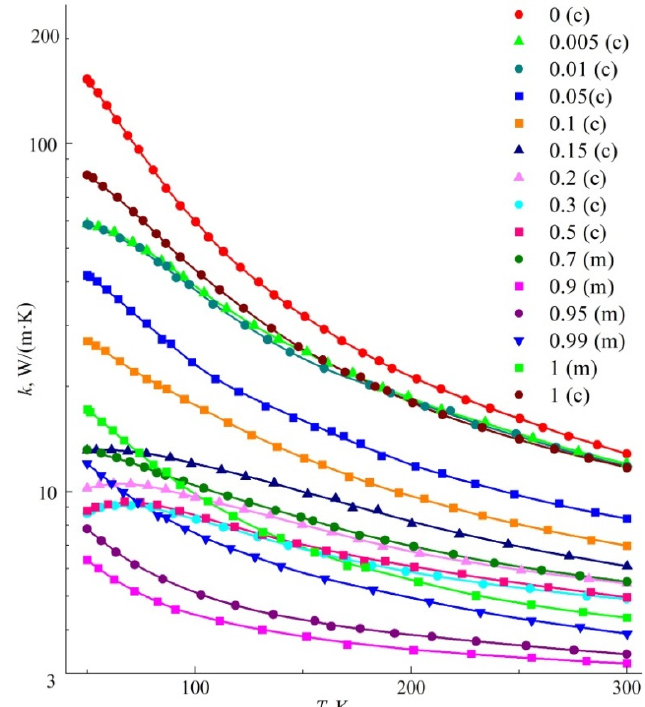
Figure 1. Temperature dependence of thermal conductivity of ceramic samples of solid solution (Y 1 − x Gd x ) 2 O 3 . In the legend, the numbers denotes x ; (c) refers to the cubic phase of the solid solution; (m) refers to the monoclinic one. Table 1. The thermal conductivity of solid solutions (Y 1 − x Gd x ) 2 O 3 at different temperatures. Gd 2 O 3 Containing,